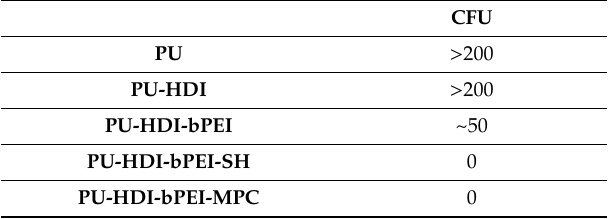
Table 3. CFU count on blood-agar Petri dishes after JIS Z2801:200 test for antimicrobial